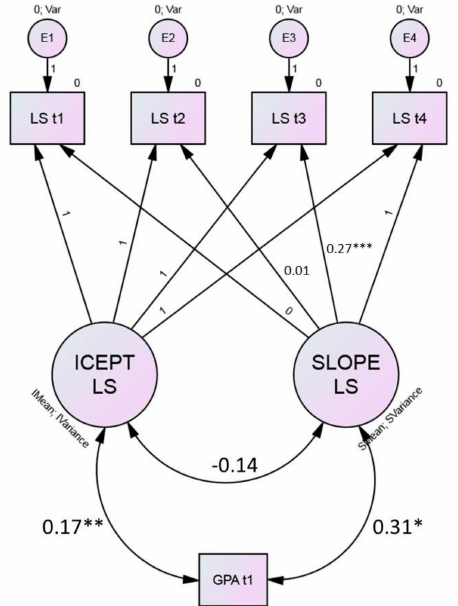
Figure 1. Sample figure for the latent growth curve model for life satisfaction (LS) with grade point average (GPA) measured at t1 as a moderator.